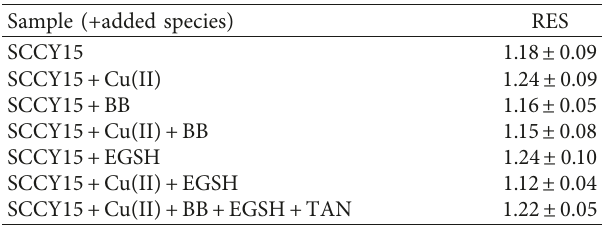
Table 4: Values for RES (mg/L) in SCCY15 refined bottled wine and treated samples (incubation: 60days, 21 sealed, dark).